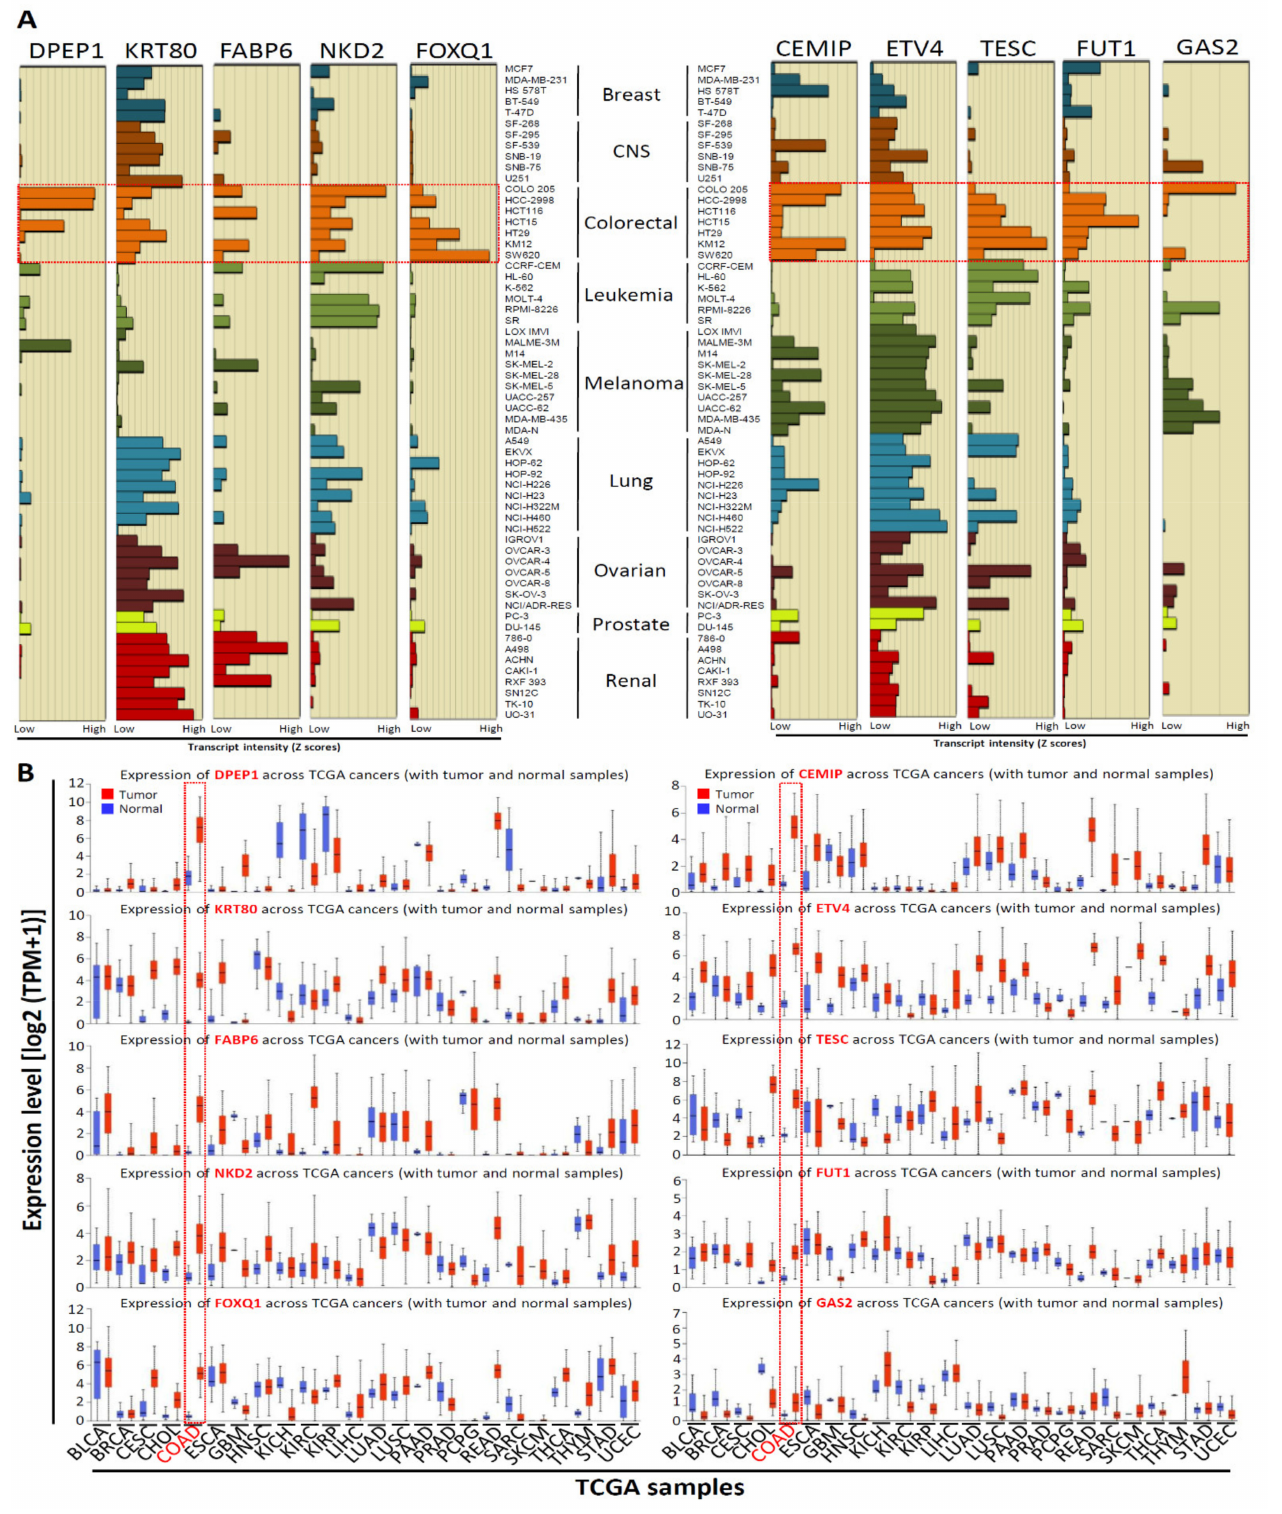
Figure 1. Top 10 upregulated CRC-associated genes mRNA expression in the National Cancer Institute (NCI)-60 human tumor cell lines and TCGA pan-cancer tissues. ( A ) Relative top 10 upregulated CRC-associated genes expression profile in National Cancer Institute (NCI)-60 cancer cell lines from the CellMiner NCI-60 analysis tool. Bars to the left show relative low expression, while bars to right show high expression. ( B ) The top 10 upregulated CRC-associated genes expression in various clinical cancer tissues were compared with those in corresponding normal tissues (UALCAN database), the red dot rectangle indicated colon adenocarcinoma